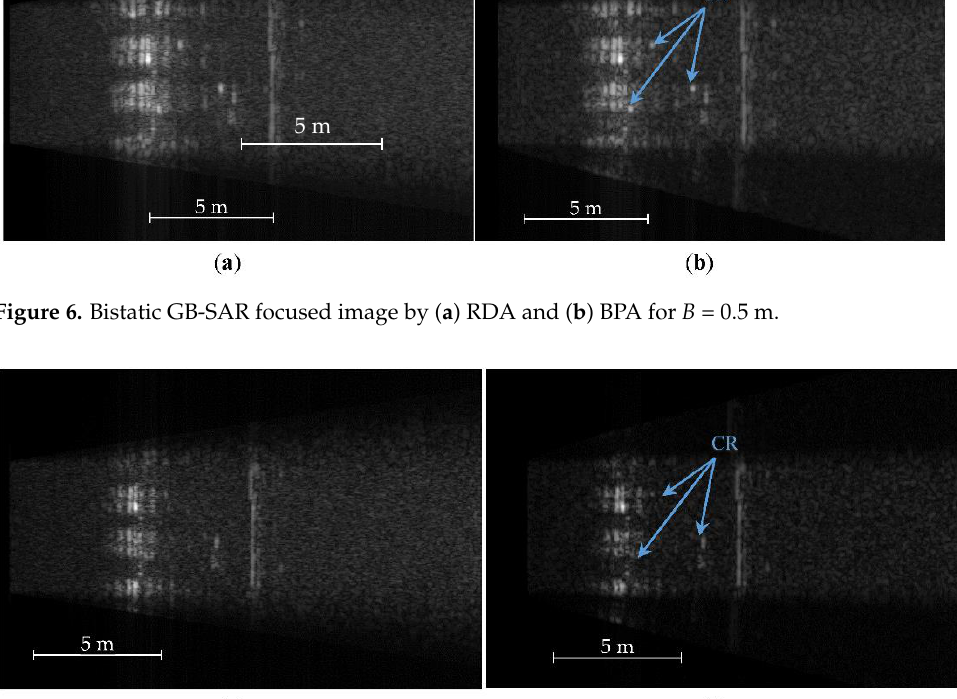
Figure 7. Bistatic GB-SAR focused image by ( a ) RDA and ( b ) BPA for B = 1 m.